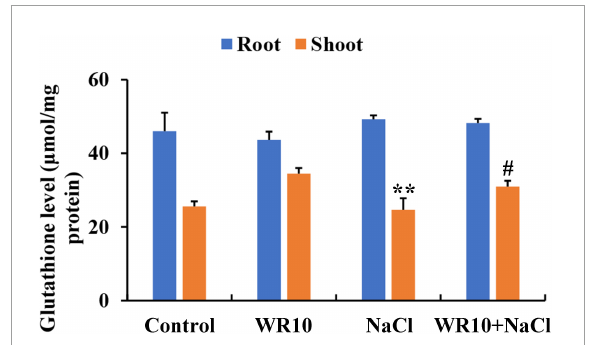
FIGURE5 Bacillus altitudinis WR10 increases GSH levels in wheat seedlings under salt stress. Control, without NaCl and WR10; WR10, with WR10 and without NaCl; NaCl, with NaCl and without WR10; WR10 + NaCl, with NaCl and WR10. Data are expressed as the means ± SD ( n = 6). ** p < 0.01 (vs. control); # p < 0.05 (vs. NaCl).